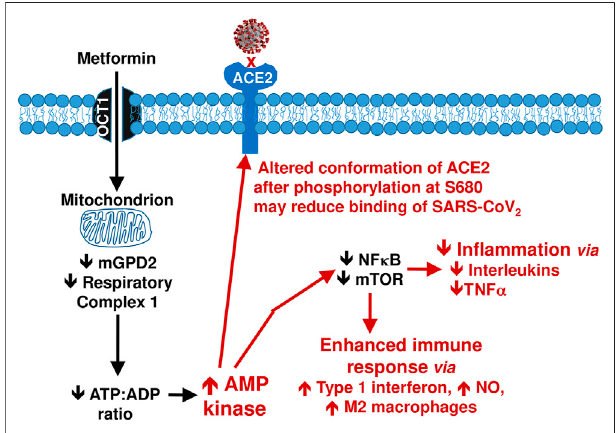
FIGURE 5 | Summary of anti-in fl ammatory mechanisms of metformin arising via activation of the AMP kinase pathway. See text for references. NO, nitric oxide; TNF α , tumour necrosis factor